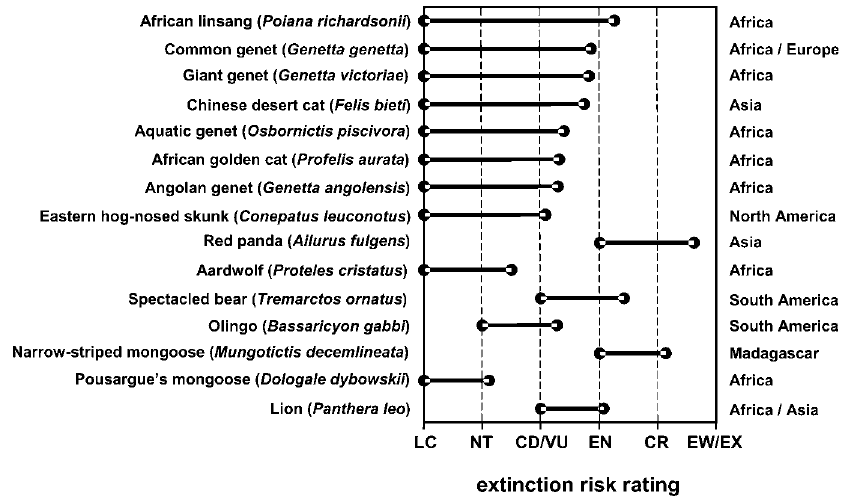
Figure 1. Carnivore Species Predicted to Move Most Rapidly towards Extinction